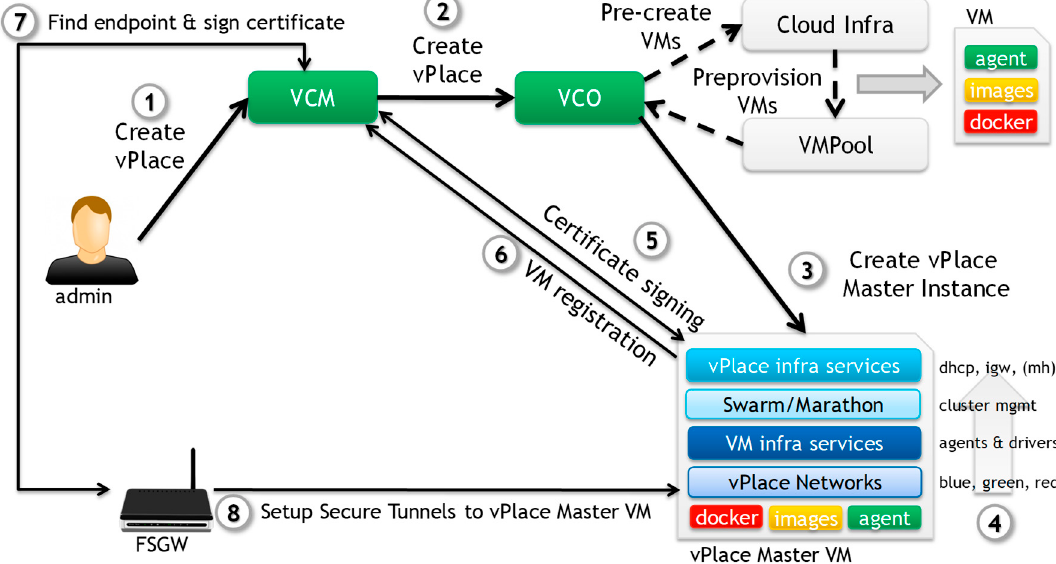
Figure 6. vPlace cloud orchestration and lifecycle management.